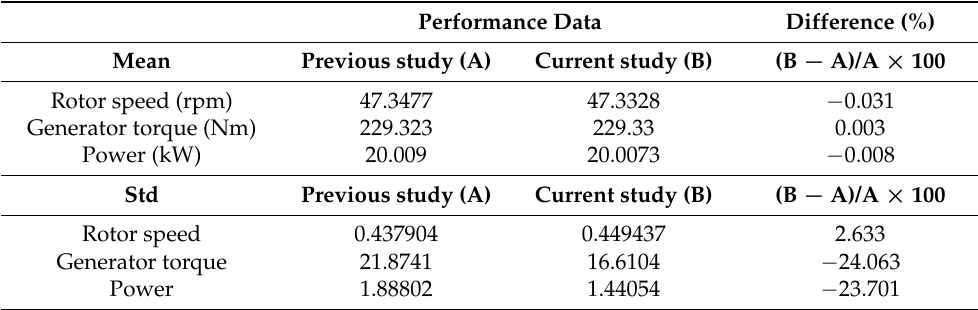
Table 7. Quantitative comparison of controller performance at an average wind speed of 16 m/s with a turbulent intensity of 17% (mostly Region